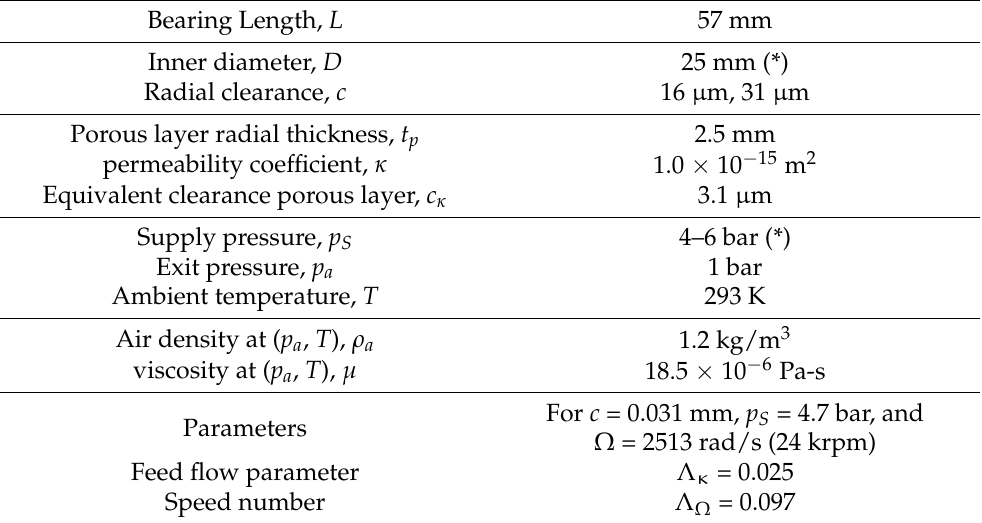
Table 3. Operating conditions and dimensions of a cylindrical PGB reported in Ref.